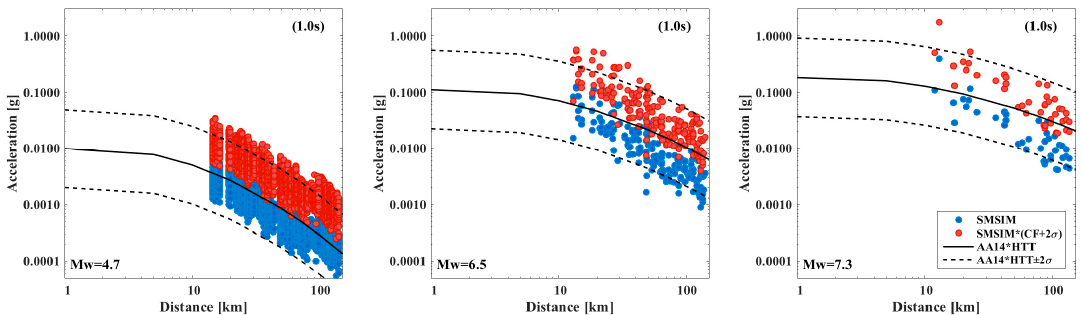
Figure 11. Mean spectral acceleration decay with respect to distance (km) predicted by AA14 ∙ HTT ± 2 σ (corrected for hard rock using HTT factors) for three different spectral periods (PGA, 0.2 s, 1.0 s), superimposed to the original SMSIM accelerations for hard rock (blue dots) and the scaled accelerations after applying a correction factor of CF+2 σ (red dots) for events of M w = [4.7, 6.5, 7.5].